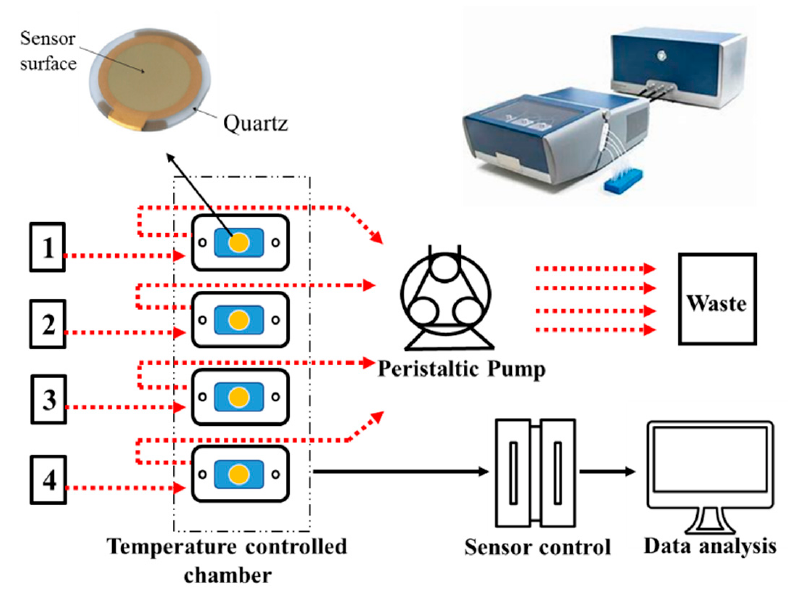
Figure 6. QCM-D instrumental setup.